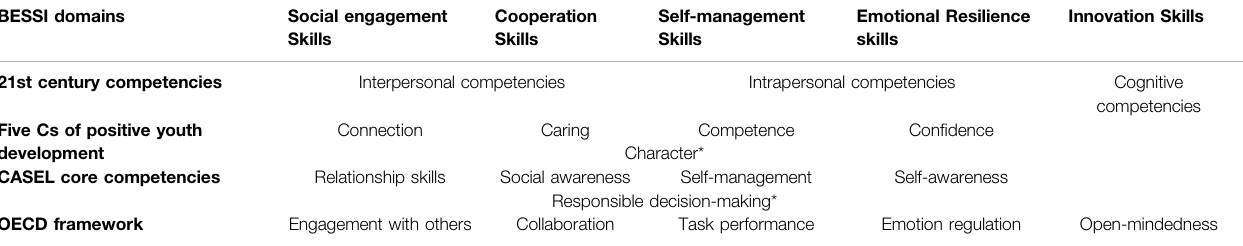
TABLE 1 | Aligning prominent taxonomies of competencies, character strengths, and skills. BESSI